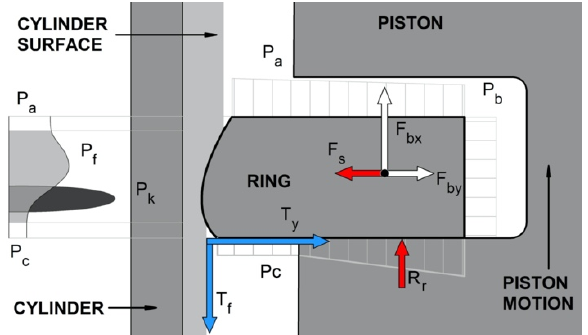
Figure 1. Forces acting on the first piston compression ring, where P a , P b , P c —pressure in volumes above, behind, and below the ring, respectively; F bx , F By —ring inertia forces, acting in the axial and radial directions; F s —ring elastic force; T f , T y —ring friction forces acting on the cylinder liner surface and piston groove shelf, respectively; P f , P k —oil film pressure and contact pressure with surface irregularities, respectively; and R r —reaction force of the piston shelf, based on ref. [29].